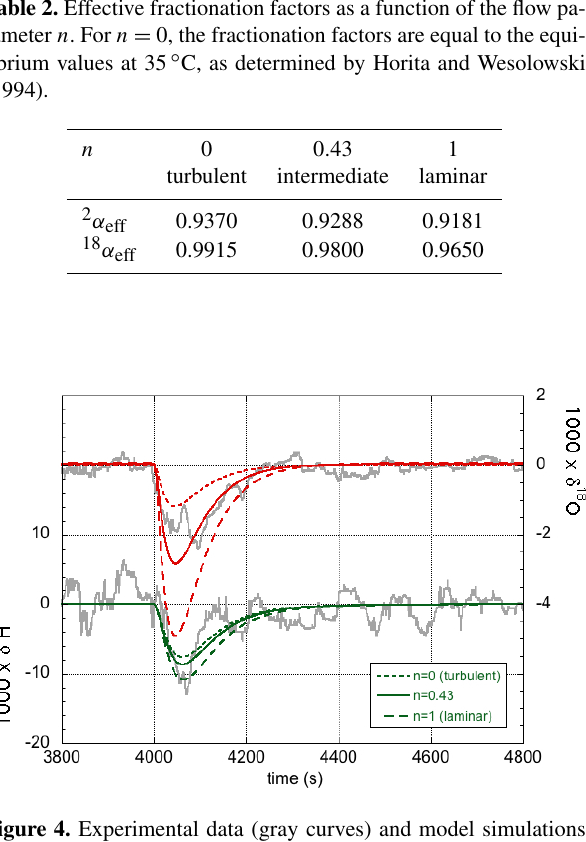
Figure 4. Experimental data (gray curves) and model simulations of the isotope response curves (green for δ 2 H and red for δ 18 O) for three different values of the flow parameter n . n = 0 (dotted lines) corresponds to the turbulent flow limit, whereas n = 1 (dashed lines) corresponds to the limit of laminar flow. For n = 0 . 43 (solid lines), a good fit is obtained for both